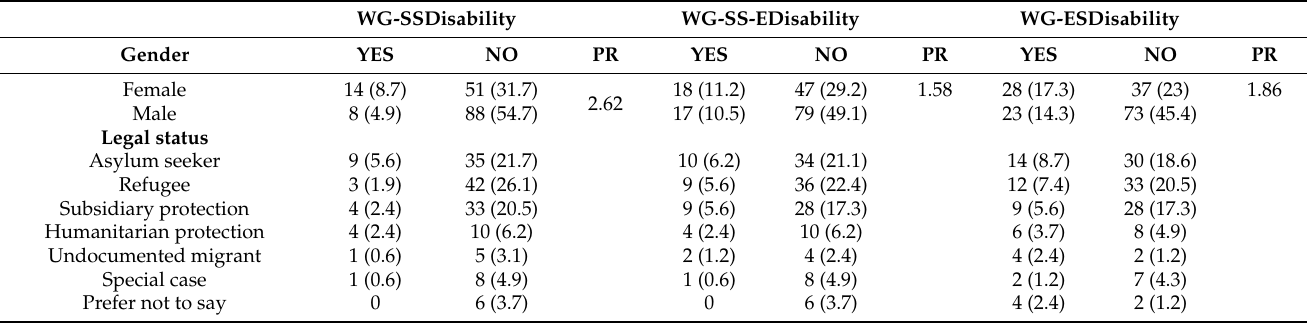
Table 4. Differences in disability status according to sociodemographic